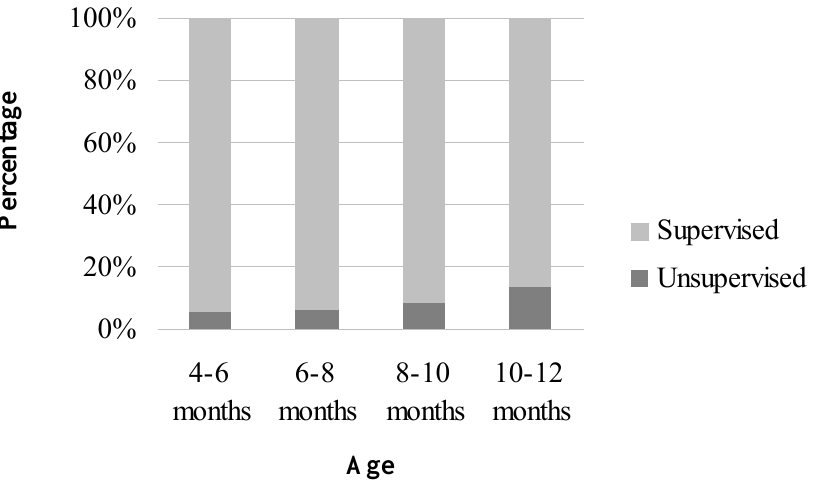
Figure 1. Percentage of children left unsupervised by age